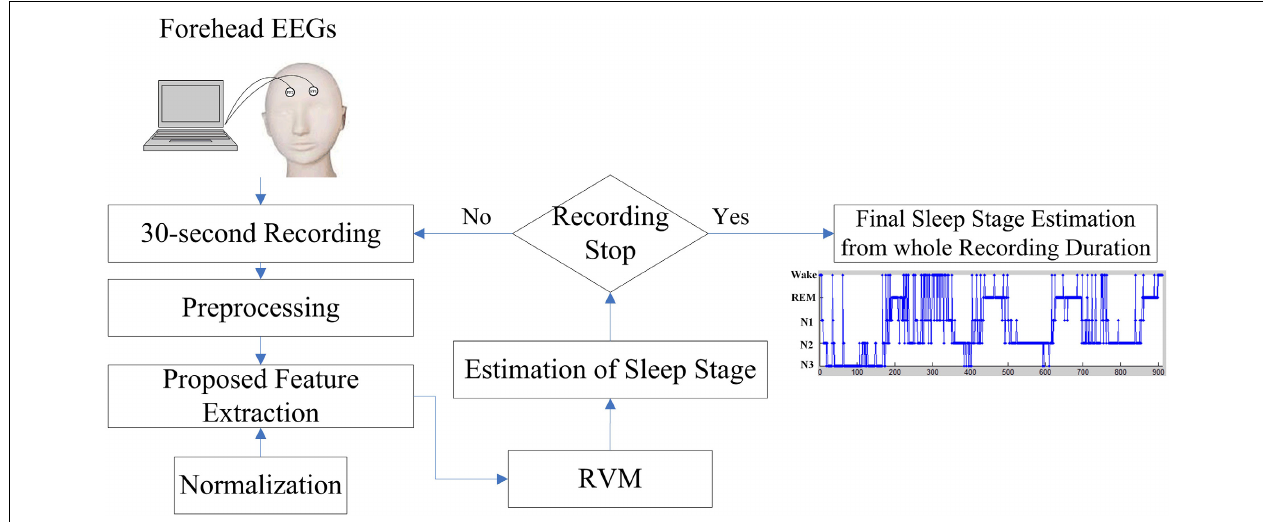
FIGURE 2 | Flowchart of the proposed sleep stage classification system based on the forehead EEG channels (FP1 and